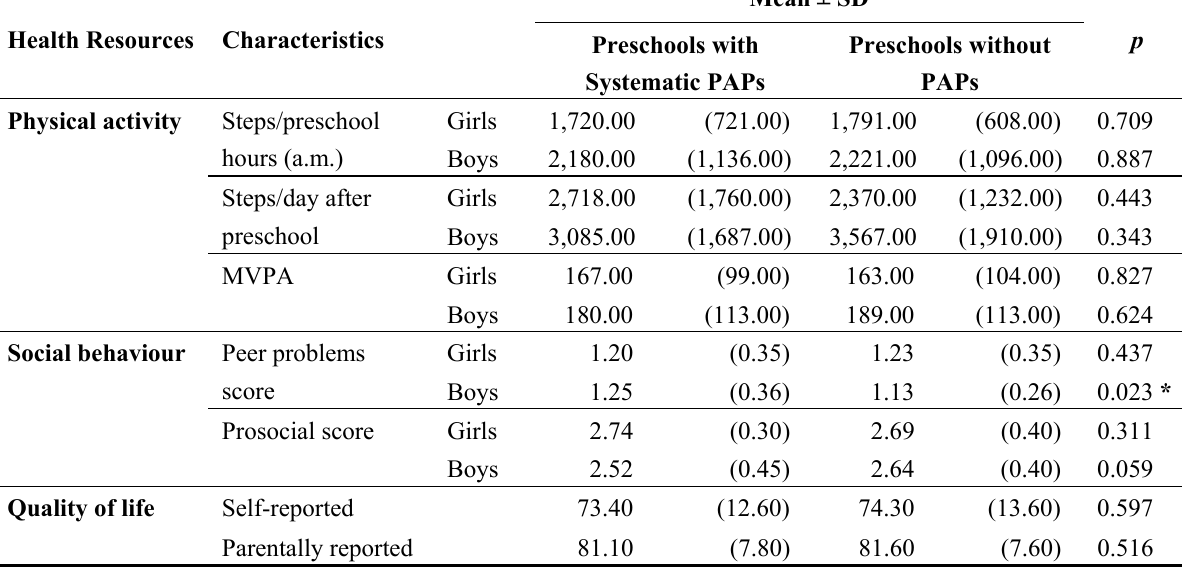
Table 2. Differences in children’s physical activity, social behaviour and quality of life according to preschool